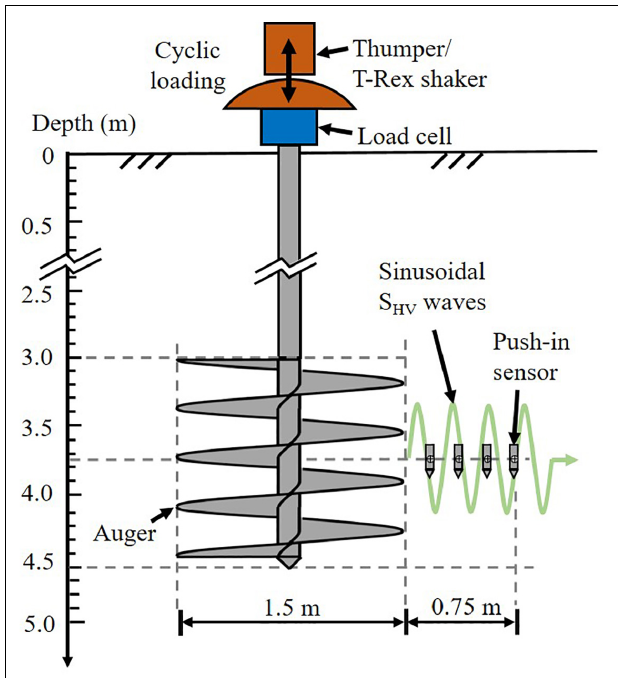
FIGURE 9 | Schematic of deep in-situ liquefaction testing using an auger.